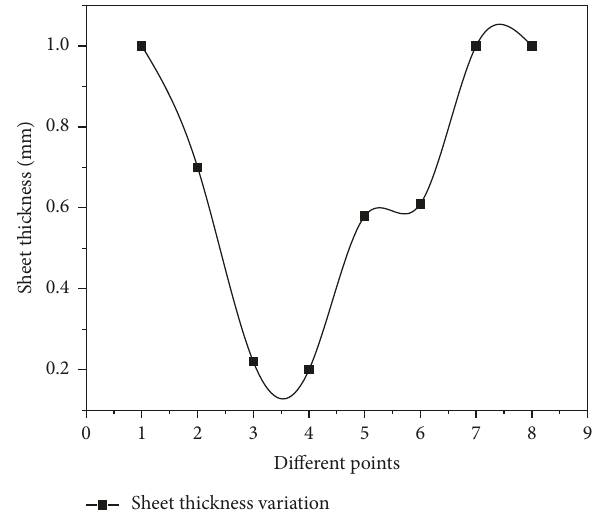
Figure 5: Thickness distribution results of sheet metal at different times of deep